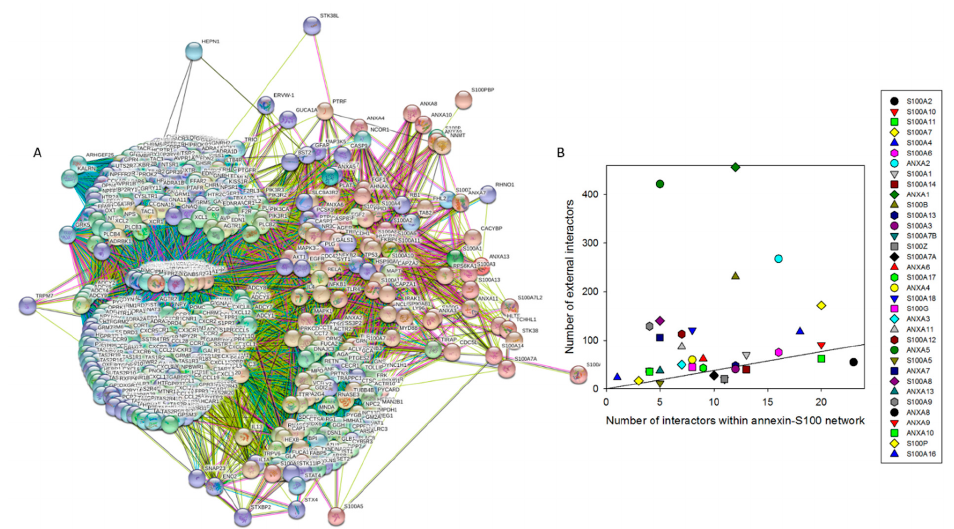
Figure 6. Evaluation of the global interactivity of human annexins and S100 proteins by STRING platform. ( A ) Global annexin-S100-centered interactome that includes 535 nodes connected by 44,201 edges. In this analysis, the medium confidence level of 0.4 was used. ( B ) Comparison of the involvement of each member of the human annexin and S100 families in annexin-S100 interfamily network and in a global annexin-S100-centered interactome.